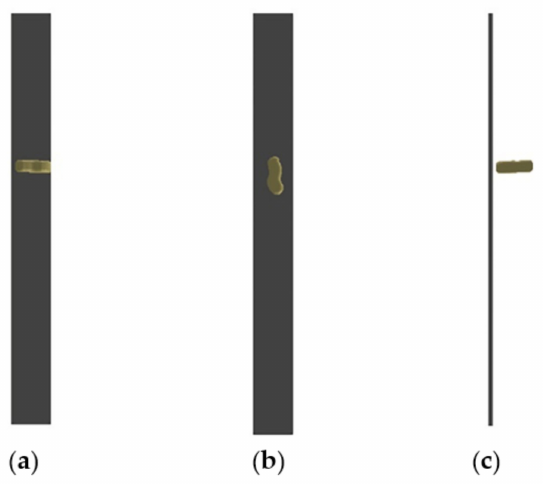
Figure 7. Peanut pod simulation model of different collision modes. ( a ) Lateral collisions; ( b ) Longi- tudinal collisions; ( c ) vertical